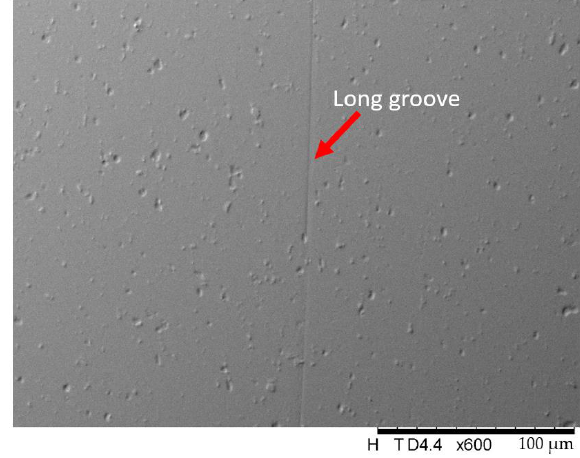
Figure 13. Long scratch on the lapped surface (rotational speed 1000 rpm, time 15 min, slurry particle: Al 2 O 3 ).